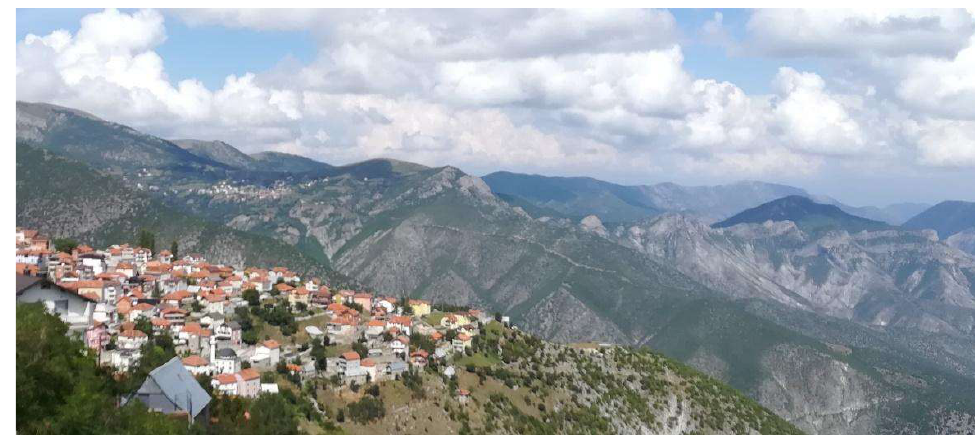
Figure 2. The village of Gurguricë (Photo: A. Pieroni).